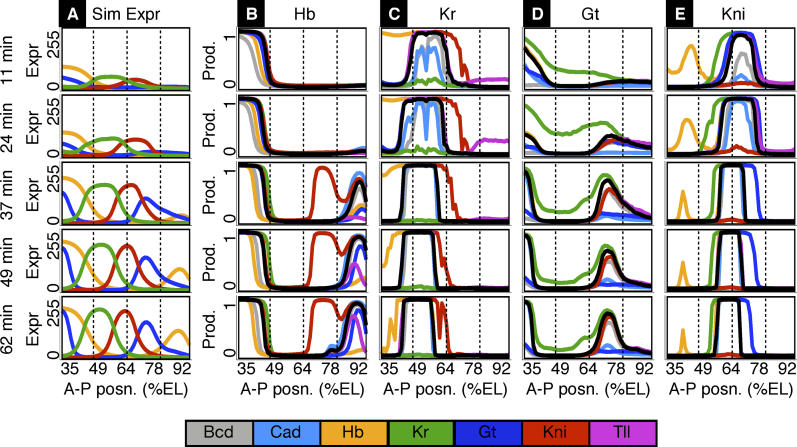
Simulated Gap Gene Expression, Production, and Regulatory Effects in the Unc-GC Model(A) Simulated expression at five of the 10 times for which we have observed data.(B–E) Production rates of Hb, Kr, Gt, and Kni, respectively, as a fraction of maximum (black curve) along with the production rate that would result when individual regulatory inputs are removed (colored curves). For example, in the plot for Hb at time t = 62 min, the yellow curve below the black curve shows what the production rate of Hb would be if, at that moment, Hb autoactivation were removed from the model, and the red curve shows what the production rate would be if repression by Kni were removed.